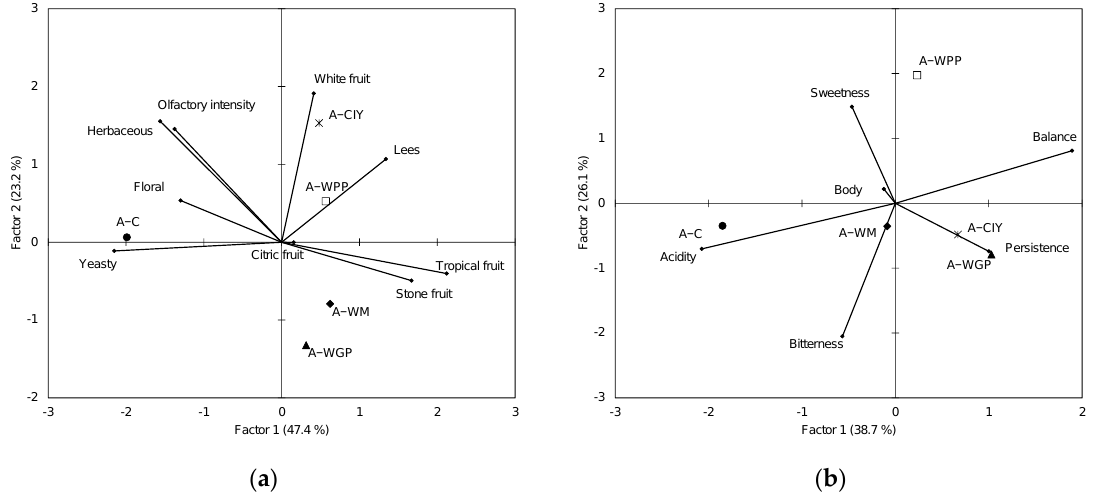
Figure 3. Generalized Procrustes analysis (GPA) of the mean ratings for ( a ) olfactory phase and ( b ) gustative phase in the Albillo wines. C: control wines, WM: wines with the addition of PSs extracted from white must, WGP: wines with the addition of PSs extracted from white grape pomace, WPP: wines with the addition of wine purified polysaccharide rich in RG-II, CIY: wines with the addition of commercial inactivated yeasts.